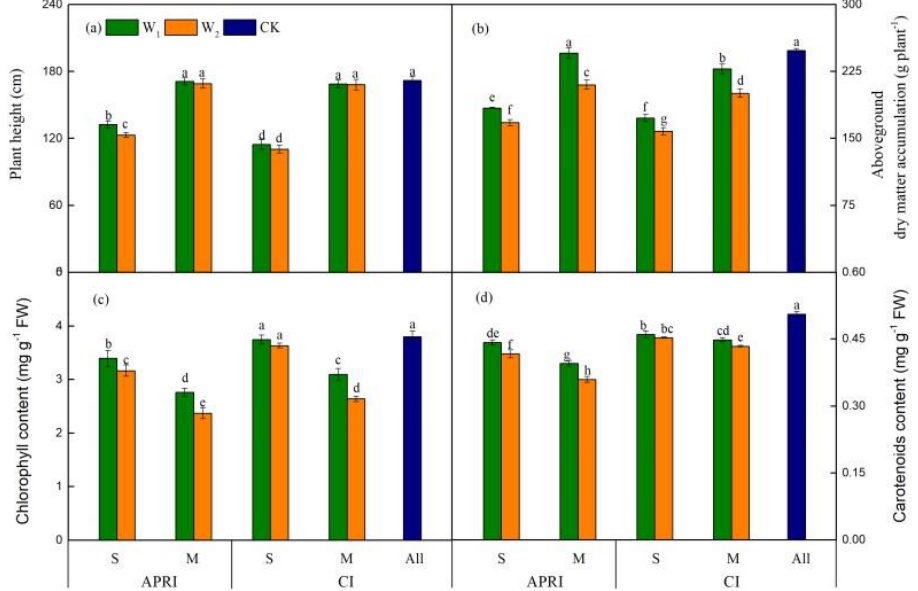
Figure 4. Effects of different irrigation levels and deficit periods on the plant height ( a ), aboveground matter accumulation ( b ), and chlorophyll ( c ) and carotenoid content ( d ) of maize under alternate partial root-zone irrigation. Different letters on top of the bar denote significant differences at p < 0.05 according to the Duncan test.